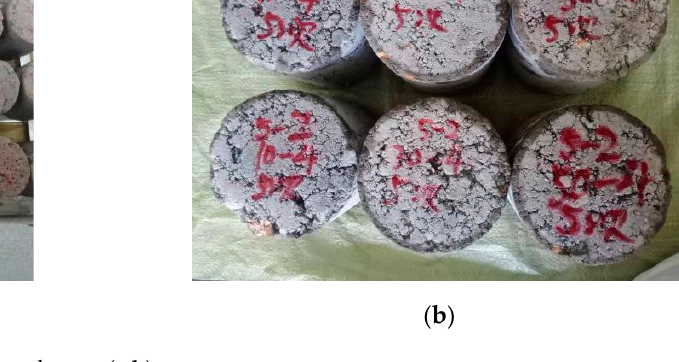
Figure 2. Freeze-thaw cycle test: ( a ) and ( b ).